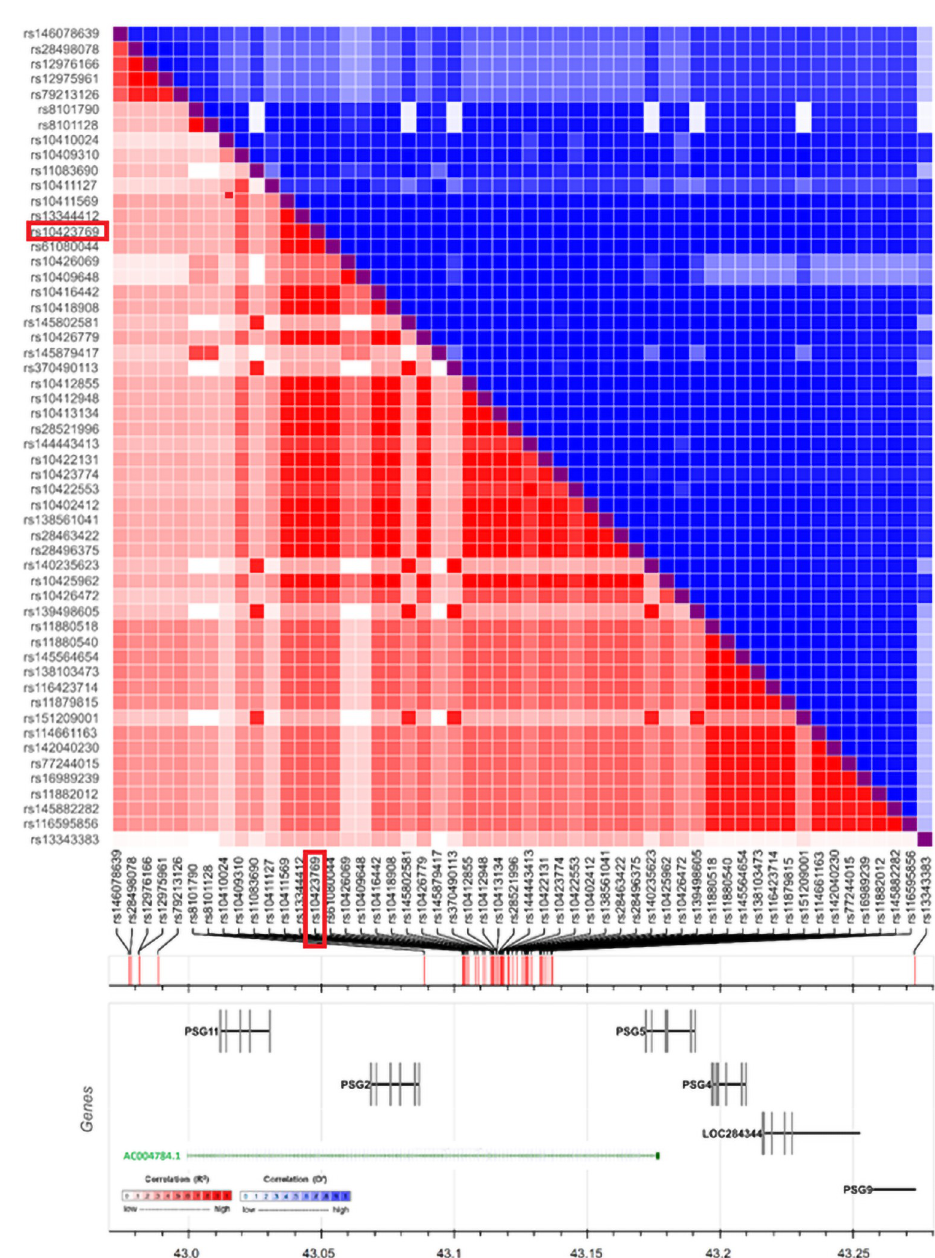
Fig 4. The plot illustrates the Linkage Disequilibrium (LD) heatmap surrounding the rs10423769 variant. The LD matrix was constructed based on r 2 (red color squares) and D 0 (blue color squares) measurement for all pairs of variants. “Genes” panel illustrates the genes that are overlapping with the LD